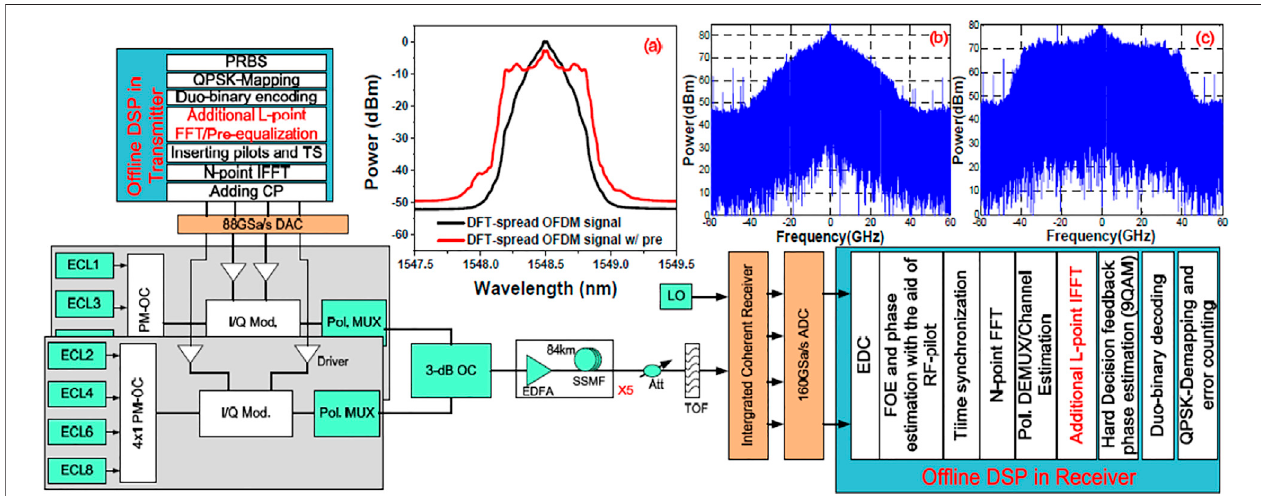
FIGURE2| Experimentalsetup (ECL: external cavitylasers;DAC: time-division Multiplexer;I/QMod.:IQmodulator; Pol.MUX:polarization multiplexer; OC: optical coupler; ATT: attenuator; TOF: tunable optical fi lter; LO: local oscillator; ADC: analog-to-digital convertor). Insets: (A) 114 Gbaud FTN-QPSK-OFDM optical spectrum, 114 Gbaud FTN-QPSK-OFDM electrical spectrum (B) without and (C) with pre-equalization.